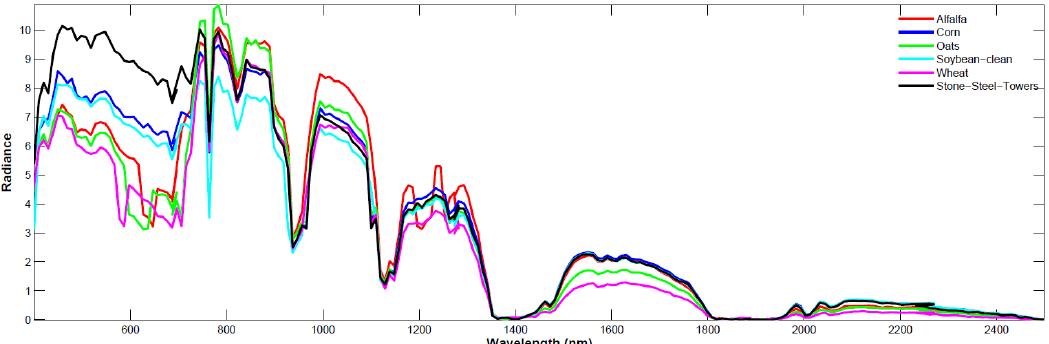
Figure 1. Spectral curves of five classes of substances in the AVIRIS (Airborne Visible/Infrared Imaging Spectrometer) 92AV3C